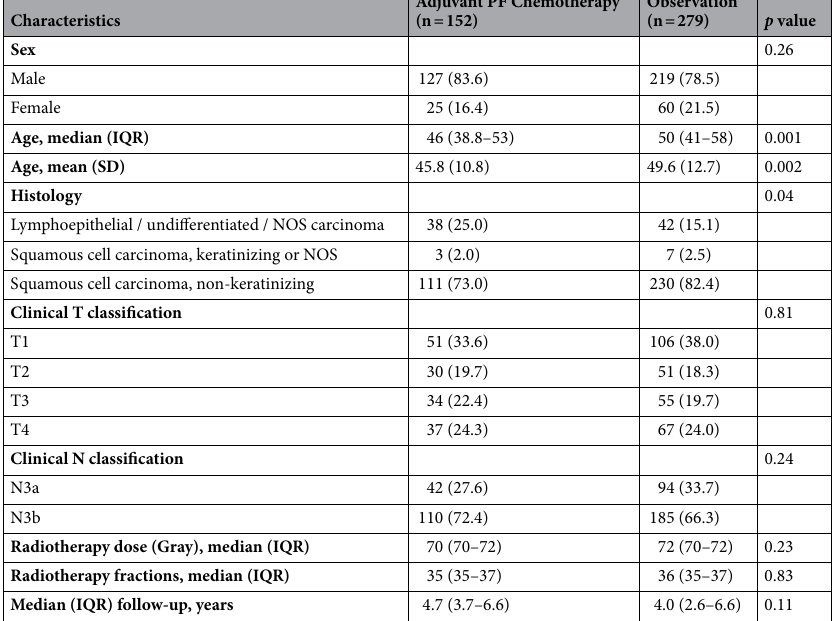
Table 1. Baseline patient and tumor characteristics (n = 431). IQR, interquartile range; SD, standard deviation; NOS, not otherwise